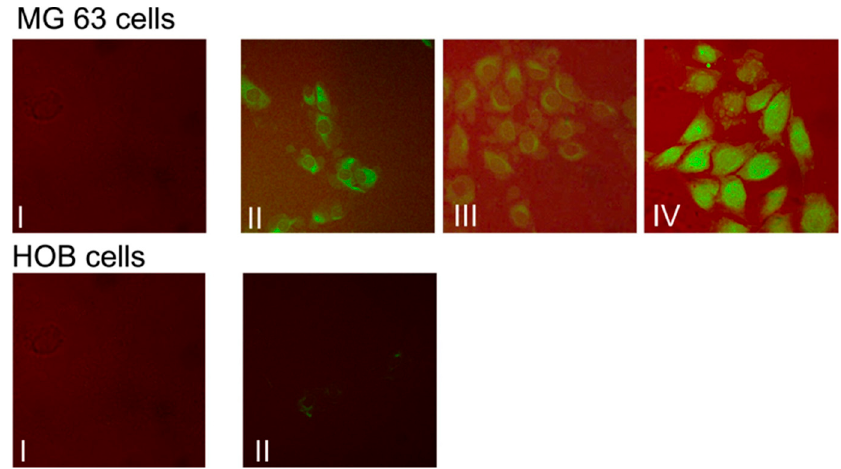
Figure 5. Micellar curcumin uptake in bone cells; 20 µ M non-loaded assemblies (I) and micellar curcumin (II–IV) were exposed to MG63 osteosarcoma cells and normal human osteoblasts (HOB) for 30 min (I, II); 1 h (III), and 2 h (IV) (from [126]).